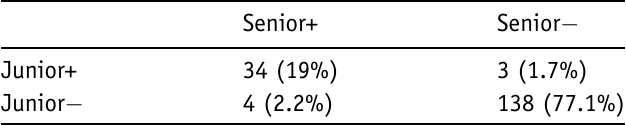
Table III. Inter-observer agreement on the decision to biopsy at least one lesion after examining the patient with IL and AF.